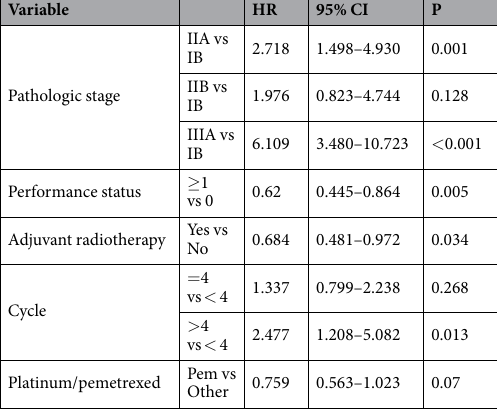
Table 2. Multivariate Cox proportional hazards model of disease-free survival.